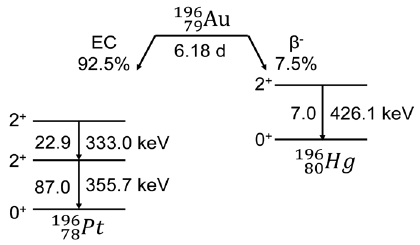
Figure 6. 196 Au decay paths.